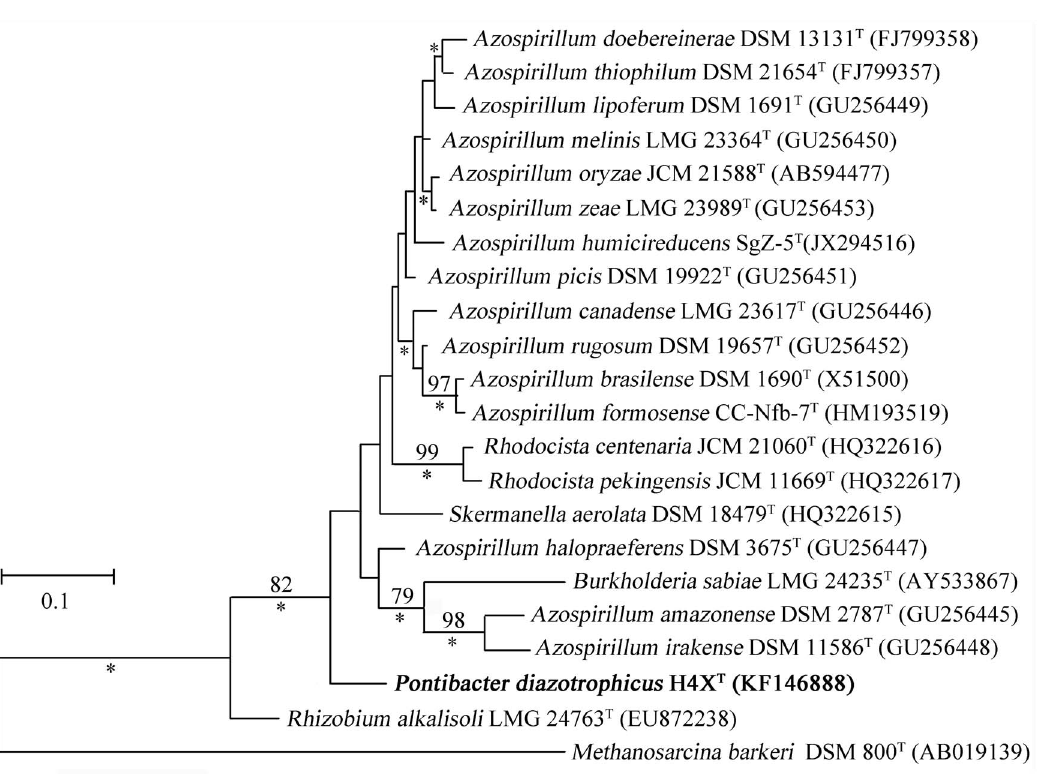
Figure 3. Maximum-likelihood tree based on multiple sequence alignment of the nifH genes from Pontibacterdiazotrophicus sp. nov. H4X T and other closely related bacterial strains. Bootstrap values (expressed as percentages of 1000 replicates) that are . 75% are shown at branch points. Asterisks indicate that the corresponding nodes were also recovered in the Bayesian tree. Bar, 0.1 substitutions per nucleotide position. degree of sequence homology between the nifH gene of the strain H4X T and those of other bacterial species from the desert.